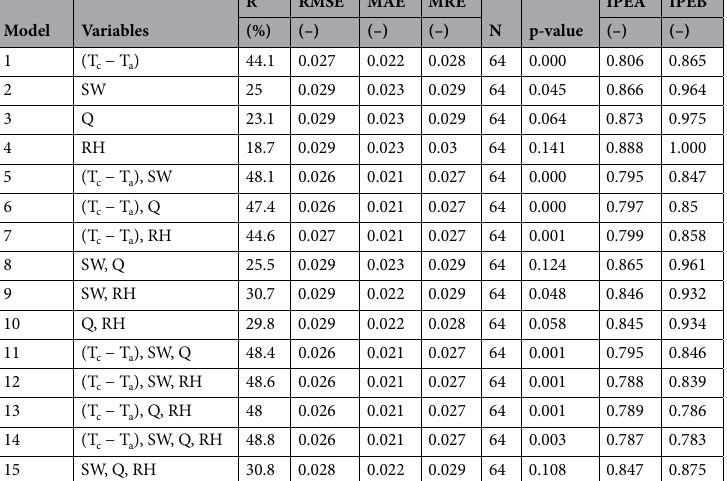
Table 11. Linear different models and statistical parameters for RWC estimating. R is correlation coefficient; RMSE: root mean square error; MAE: mean absolute error; MRE: mean relative error; IPE: Ideal Point Error; N is the number of